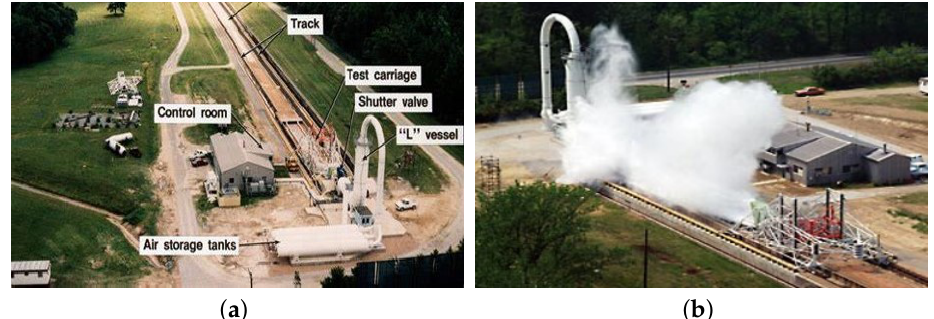
Figure 12. NASA Langley Aircraft Brake Experiment Center and tribosystem schematic diagram. ( a ) NASA Langley Aircraft Brake Experiment Center; ( b ) Aircraft landing tribosystem.